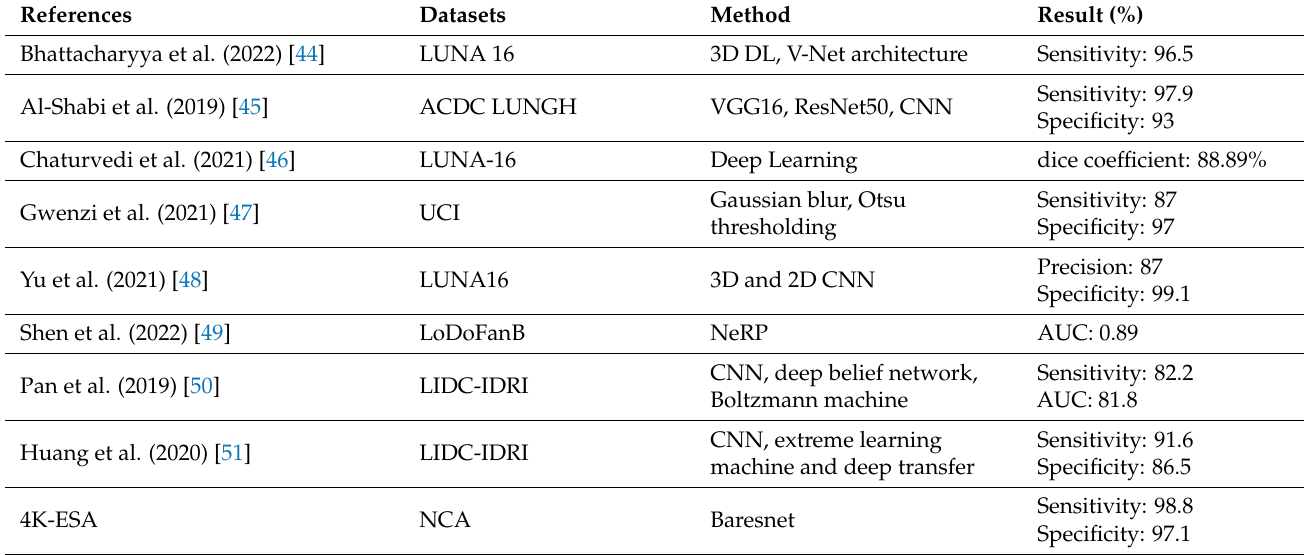
Table 4. Comparison to the state of the art with